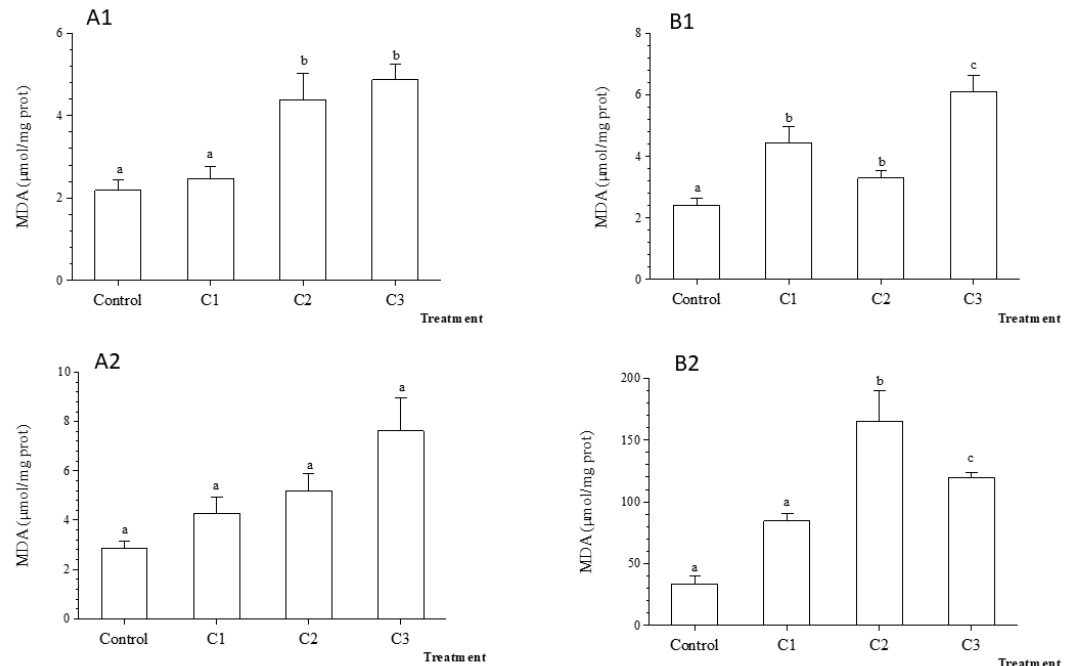
Figure 8. Average Malondialdehyde (MDA) rate ( ± standard deviation) in the freshwater mussel Unio ravoiseri after exposure to Control and three concentrations of Titanium dioxide nanoparticles during 48 h and 7 days in gills, respectively ( A1 ) and ( A2 ) and in digestive gland ( B1 ) and ( B2 ). Bars represent the group means ± SE; a, b, c, d: data not sharing a common letter are significantly different using Tukey’s HSD test ( p < 0.05).